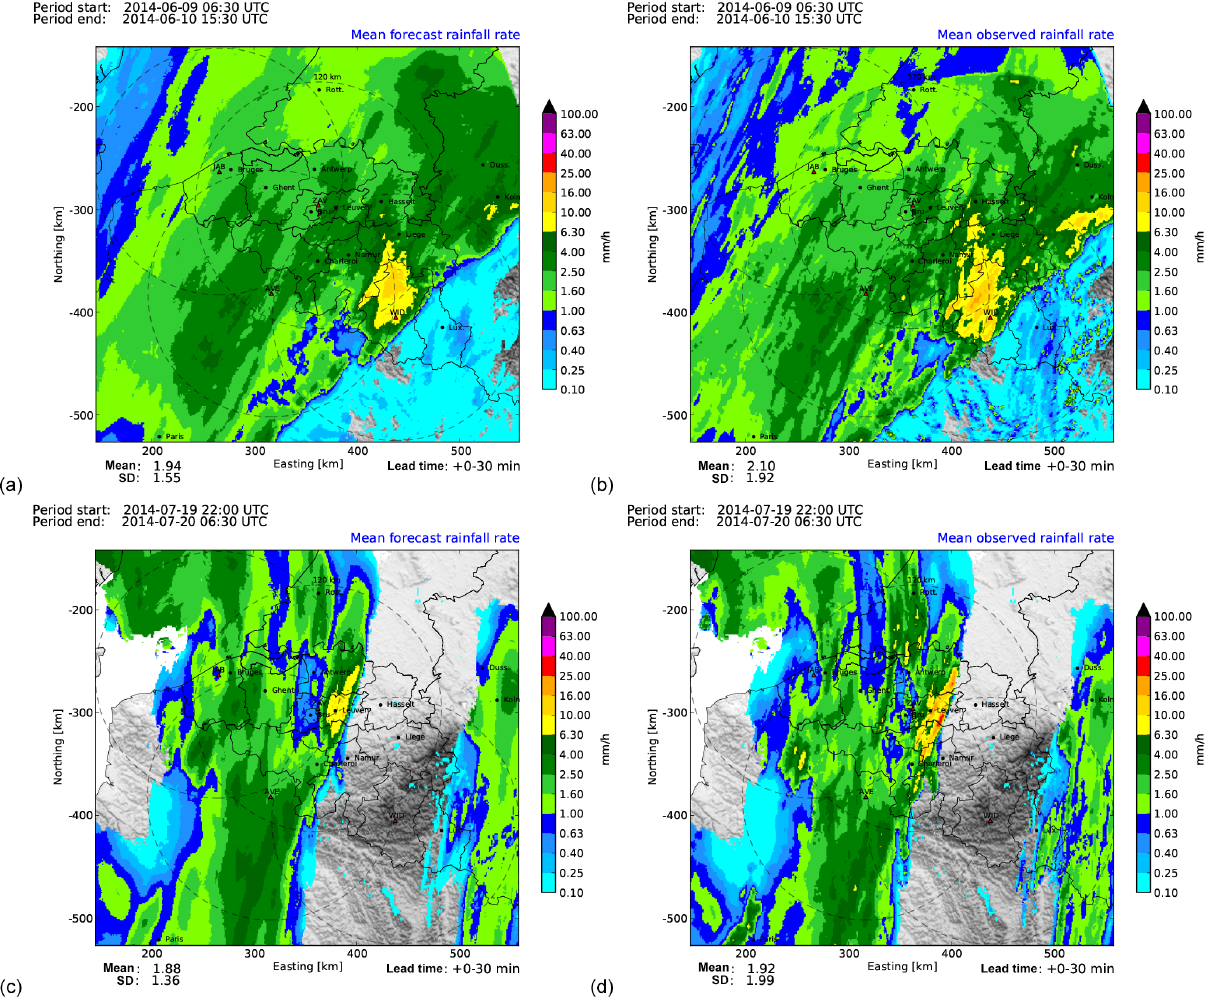
Figure 3. Average observed and forecast rainfall accumulations for the Leuven cases. (a) Forecast and (b) observed 0–30min rainfall accumulations on 9–10 June 2014. (c) Forecast and (d) observed 0–30min rainfall accumulations on 19–20 July 2014.